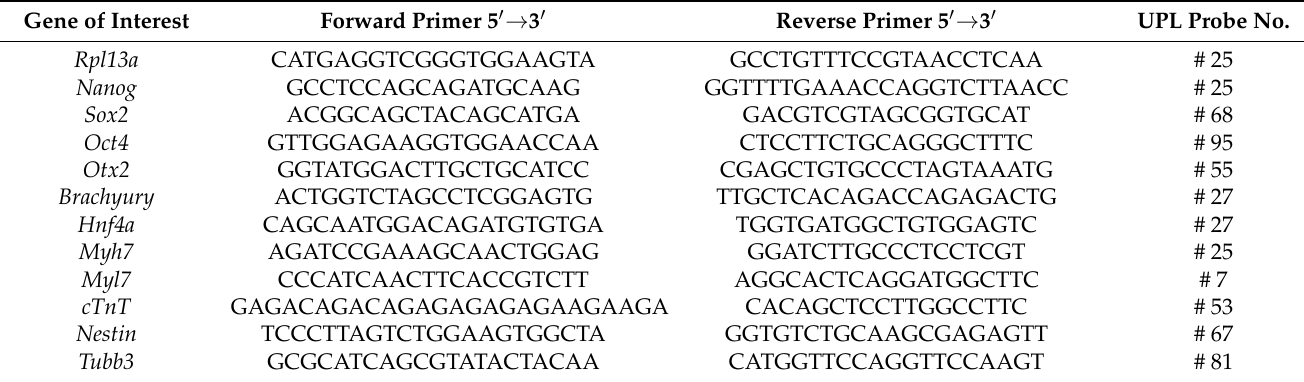
Figure 2. NO 2 -OA-dependent STAT3 signaling regulation is responsible for the reduction of mESC stemness in LIF rich medium. ( A ) Time-scheme of the mESC treatment used in this experiment. ( B ) Protein levels of phospho-STAT3 and total STAT3 were detected by Western blot in mESC pre- Table 1. min by NO 2 -OA or OA (10 µ M). The densitometric analysis was calculated from four independent experiments, and data are expressed as means and standard deviation. Statistical significance was determined by unpaired student’s t -test; statistical differences compared to non- treated control were analyzed, ** p < 0.01. ( C ) Representative Western blot analysis showing the protein levels of phospho-ERK2/ total ERK2 ( n = 3) and phospho-AKT/ total AKT ( n = 2) in mESC pre-incubated for 1 h in medium + LIF + 7.5% FBS and then treated for 15 min by NO 2 -OA or OA (10 µ M). Table 1. Sequence of primers used in quantitative